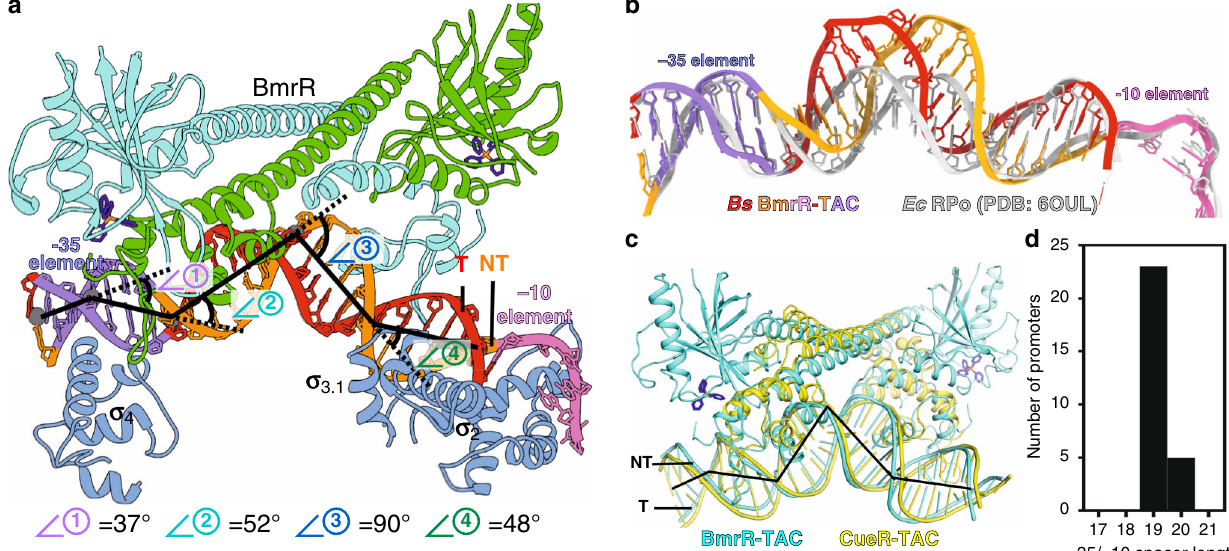
Fig. 4 BmrR and RNAP induce four kinks of upstream promoter dsDNA. a The kinks of the upstream promoter DNA at positions − 35 ( ∠ ① , 37°), − 31 ( ∠ ② , 52°), − 24 ( ∠ ③ , 90°), and − 18 ( ∠ ④ , 48°). The colors are as in Fig. 1. b Comparison of the upstream promoter dsDNA in BmrR-TAC and E. coli RPo (PDB: 6OUL). c The superimposition of upstream promoter dsDNA in B. subtilis BmrR-TAC (cyan) and E. coli CueR-TAC (yellow). d The distribution of promoter unwinding using an rps T2 promoter with a − 35/ − 10 spacer of 17 bp 42 . The structures show that RNAP- σ 70 fi rst